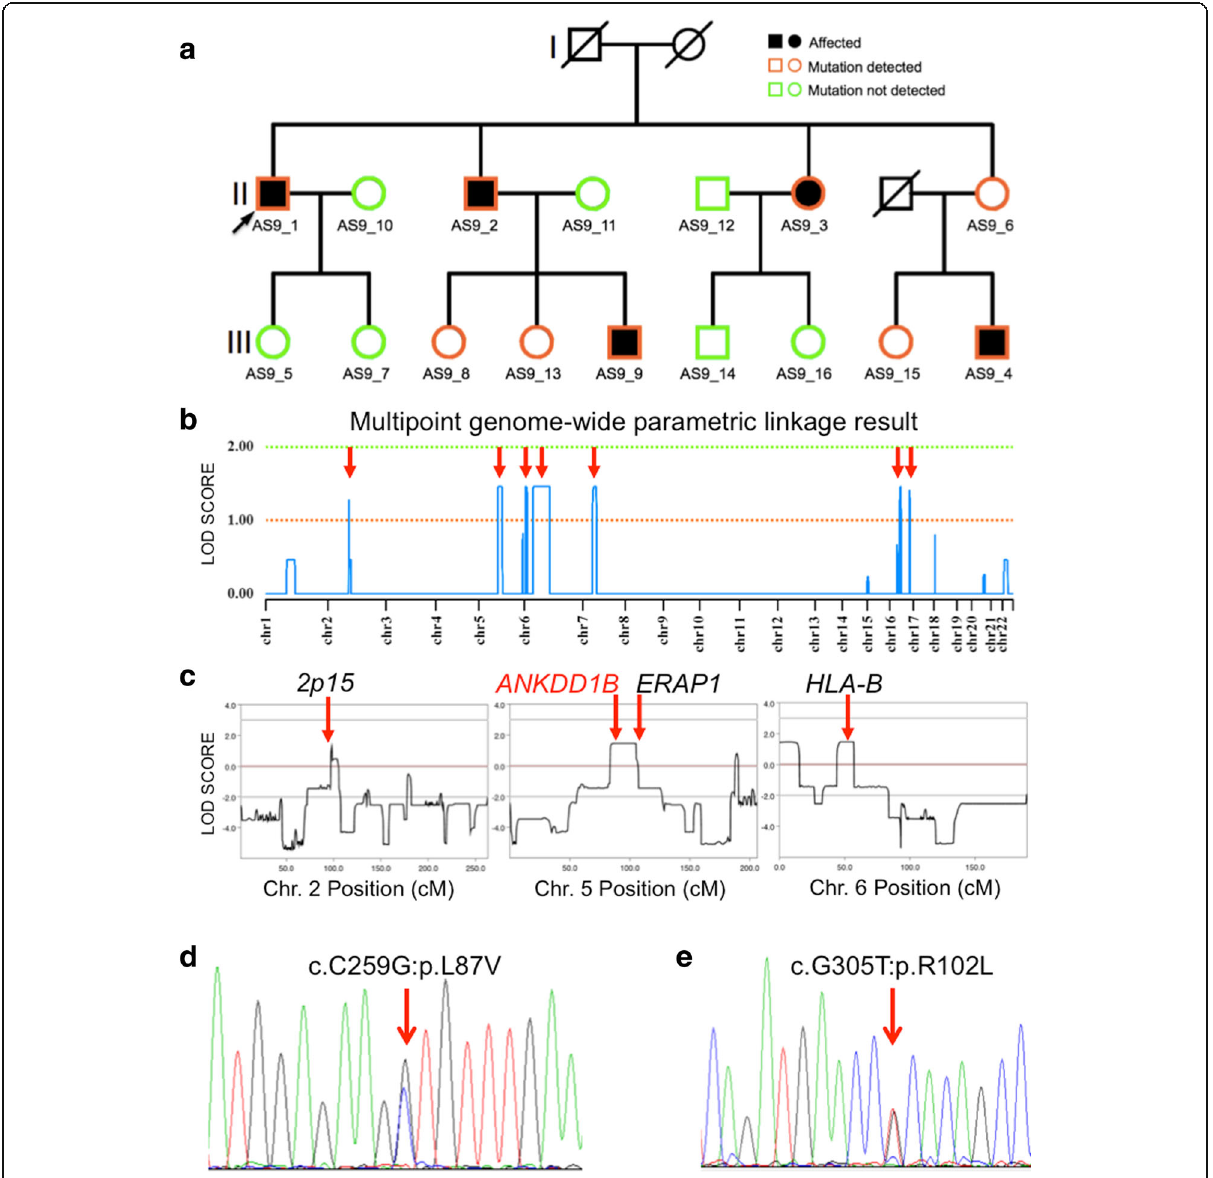
Fig. 2 Whole-genome linkage analysis and exome sequencing identified ANKDD1B to be associated with AS. a The AS9 pedigree. Generations, non-carriers, non-symptomatic carriers and patients are indicated. Arrow points to the proband. b Whole-genome linkage analysis identified seven regions (arrows) on Chr. 2, Chr. 5, Chr. 6, Chr. 7 and Chr. 16 to be significantly linked to disease transmission in the AS9 pedigree. c A delineation of the ANKDD1B locus and the major known AS risk loci in relation to the linkage regions. d , e The L87V variant and the